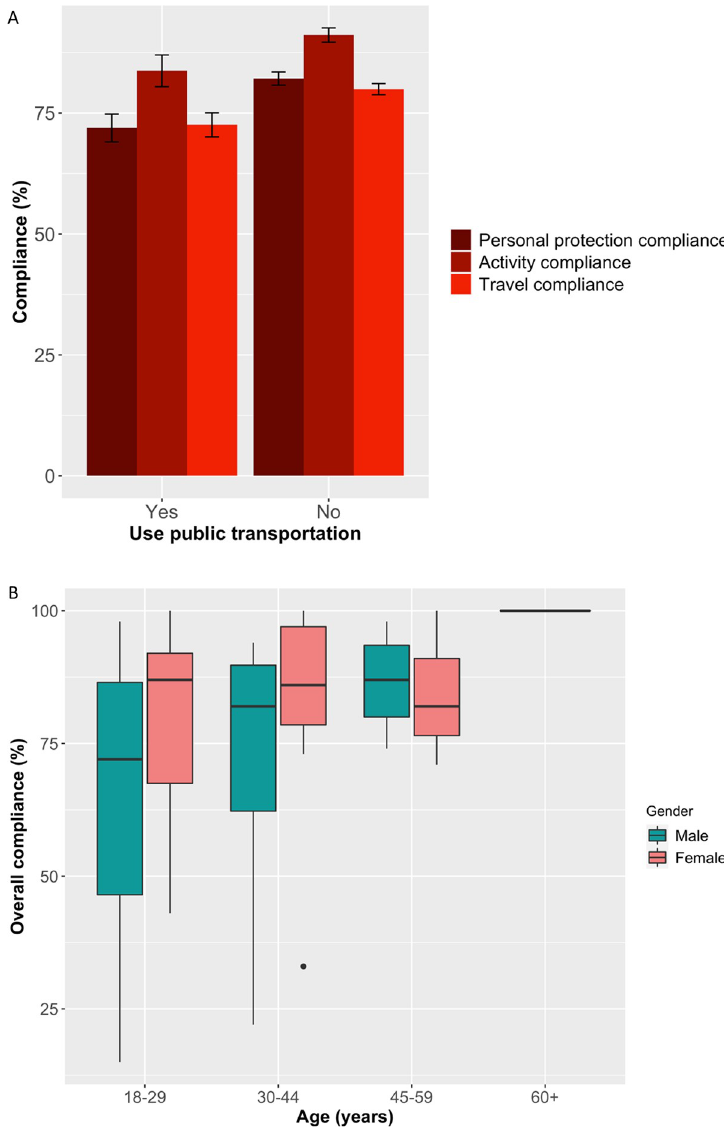
Fig 3. A. Mean compliance for each compliance component by public transport user. B. Overall compliance score of public transport users, by gender and age.